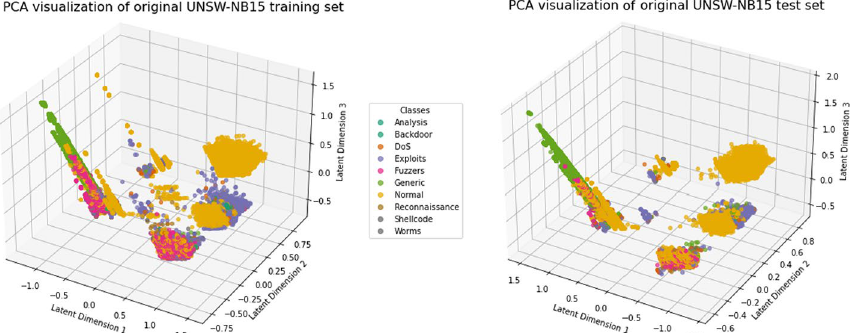
Fig. 7 The PCA visualization of original training and test